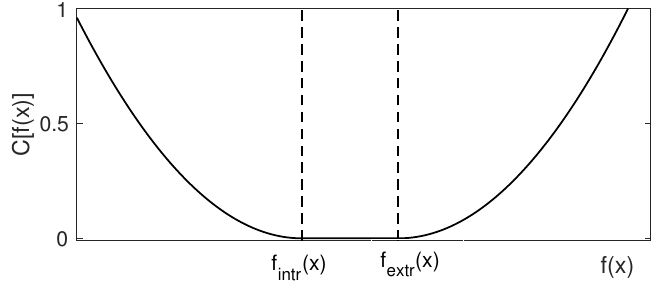
Figure 2. Approximation of the characteristic function for a generic point x